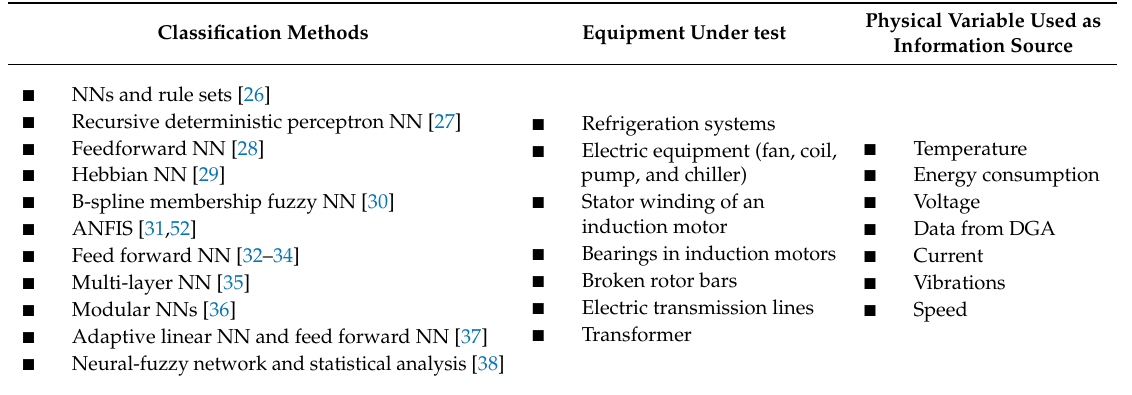
Table 1. Classification methods and their